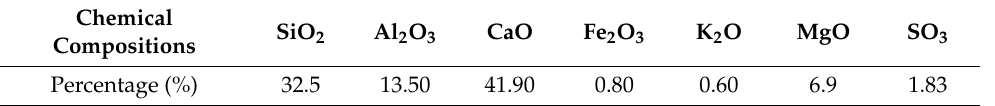
Table 4. Chemical compositions of